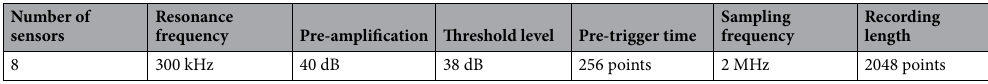
Table 2. Detailed description of the parameters AE System (PCI-2).